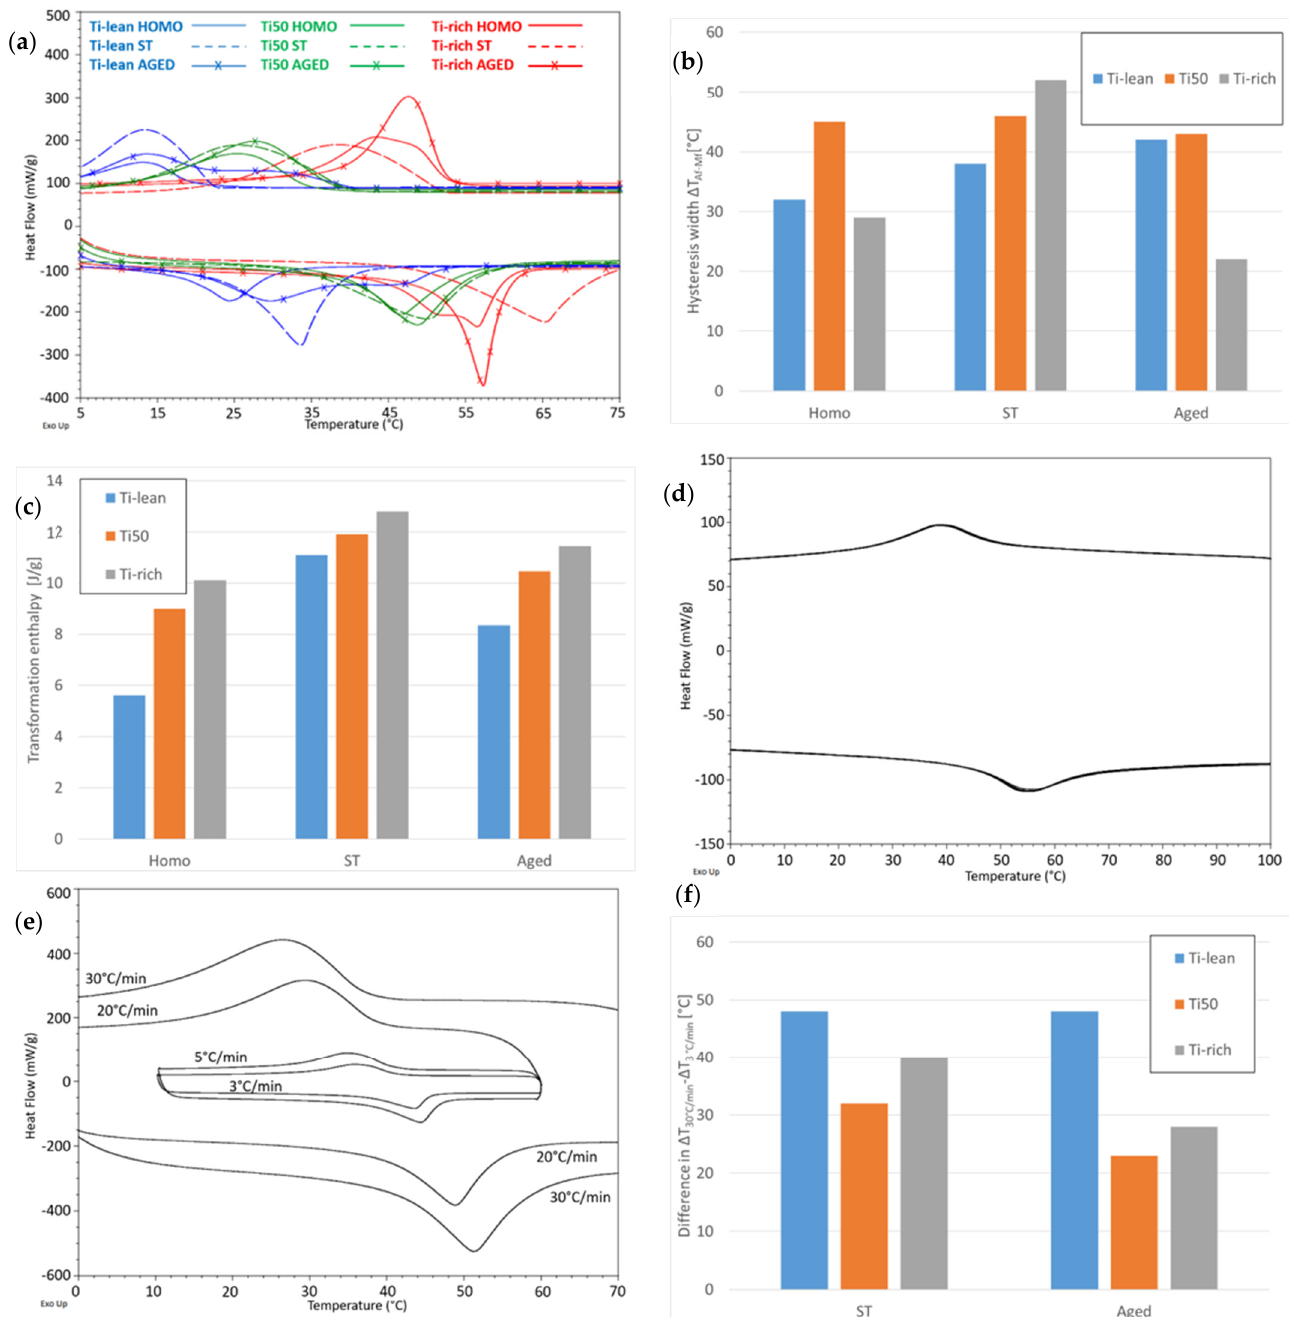
Figure 1. DSC results of group A alloys: ( a ) An overview of DSC curves after various heat treatments; ( b ) The hysteresis width of heat-treated alloys; ( c ) Enthalpy of transformation measured as the average of the forward and backward transformation; ( d ) A representative curve of the homogenized Ti 50.2 Ni 30.9 Cu 9.0 Pd 9.9 exposed to ten DSC cycles; ( e ) A representative curve of solution-treated Ti 50.0 Ni 29.1 Cu 11.5 Pd 9.4 cycled at different thermal rates ranging from 3–30 °C/min; ( f ) The growth of the hysteresis width by testing at 30 °C/min compared to 3 °C/min ( Δ T 30 °C/min − Δ T 3 °C/min ).